Question: Summarize what this figure shows in one sentence.
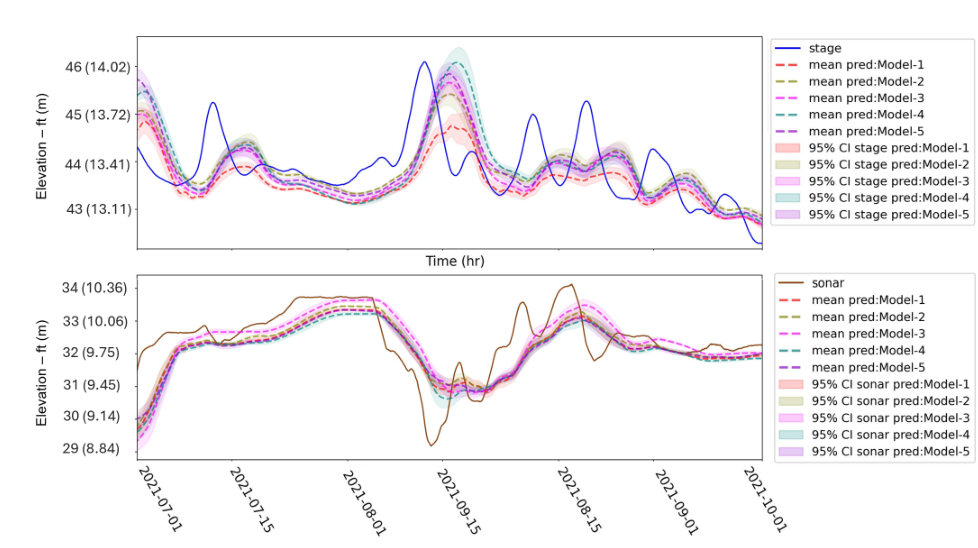
Answer: Stage (top) and Sonar (bottom) predictions of top-5 LSTM models selected by the random-search (meanMAE policy), mean and 95% confidence intervals over the test dataset - Alaska bridge 230.